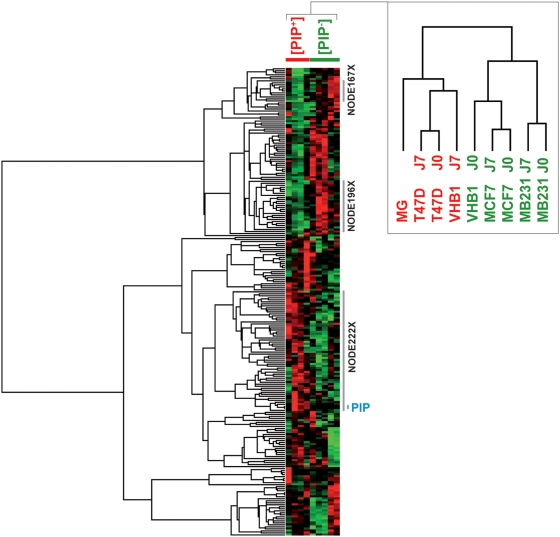
Hierarchical clustering of the differentially expressed genes.Unsupervised hierarchical clustering of all samples for the genes found significantly differentially expressed (L235) between [PIP+] and [PIP−] phenotypes, and modulated in relation with the PIP expression. Genes (row) and samples (columns) are clustered independently using uncentered Pearson correlation metrics. [PIP+] and [PIP−] cell lines are indicated in red and green, respectively. The top-ranked relevant gene clusters (NODE 167X, NODE 196X and NODE 222X) selected using t-statistics with permutation-based adjustment (n = 10,000; α = 0.05) are indicated by color bars. The presence of the PIP gene is pointed.